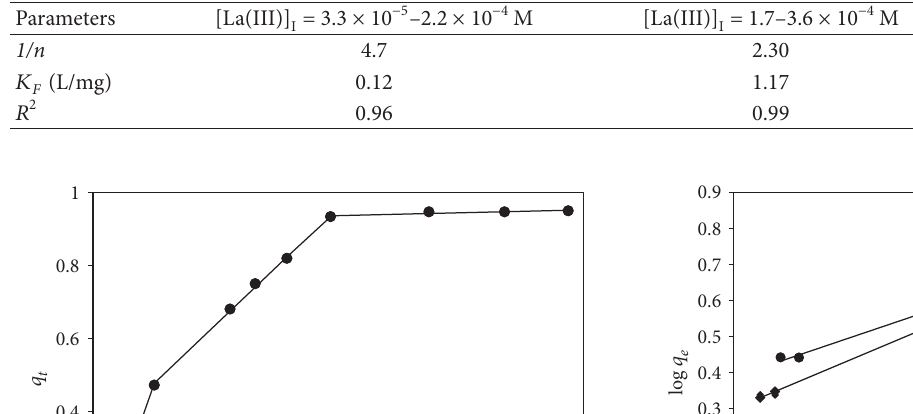
T 3: Parameters of the Freundlich model ( ) applied to experimental data for La(III) and Eu(III) adsorption = 5.75 on hydroxyapatite at room temperature and pH eq